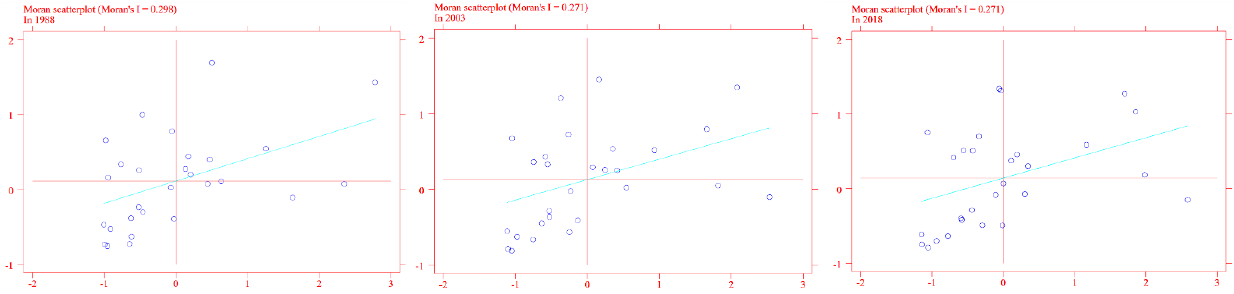
Figure 2. Moran scatter diagram. Data source: The third, sixth, and ninth Forest Resources Inven- tories.